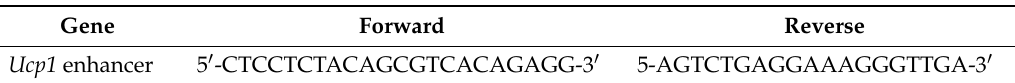
Table 2. Primers used in ChIP assay.